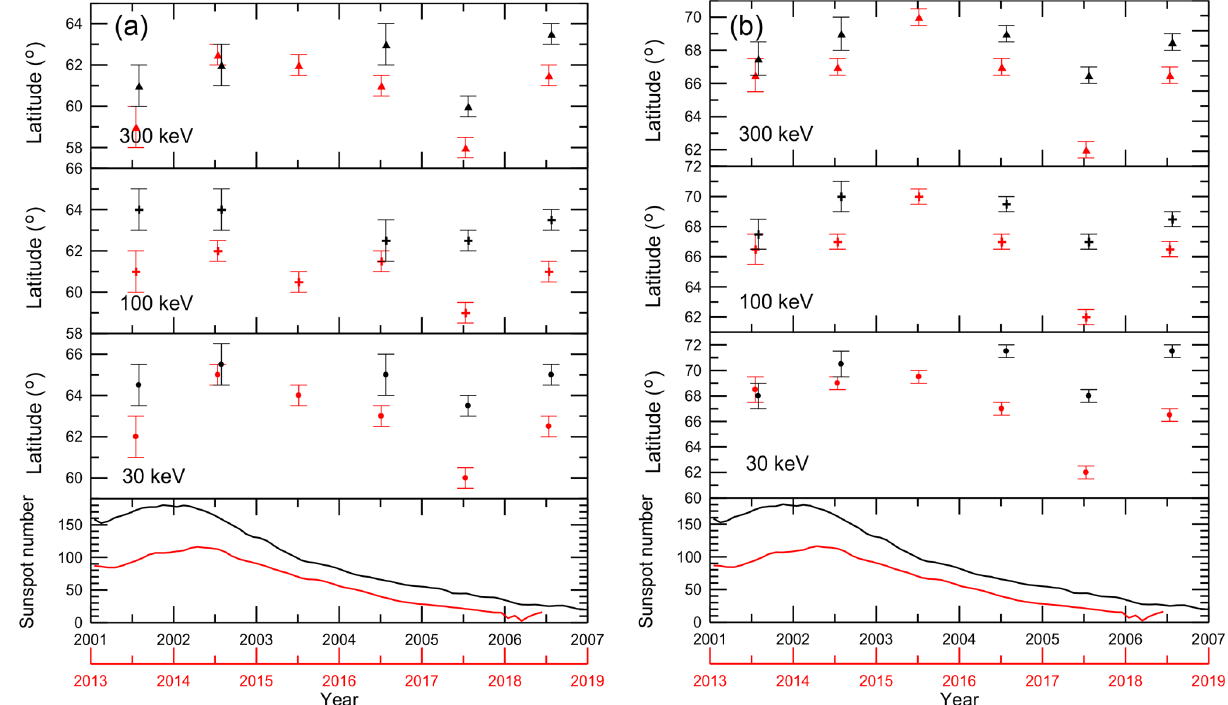
Figure 6. Geographic latitude of the inner edge (a) and maximum (b) of the outer radiation belt measured during geomagnetic quiet days at a height of ∼ 850km around a longitude of 100 ◦ E for electrons with energies of >30keV (circles), >100keV (crosses) and >300keV (triangles). Bottom panels show the sunspot number in the 23rd solar cycle (2001–2006, black curves) and in the 24th solar cycle (2013– 2018, blue curves). The outer radiation belt location is shown using black and red symbols for the 23th and 24th solar cycles, respectively. It can be seen that the ORB is systematically located at lower latitudes during the declining phase of the 24th solar cycle compared with the its location during the 23rd solar